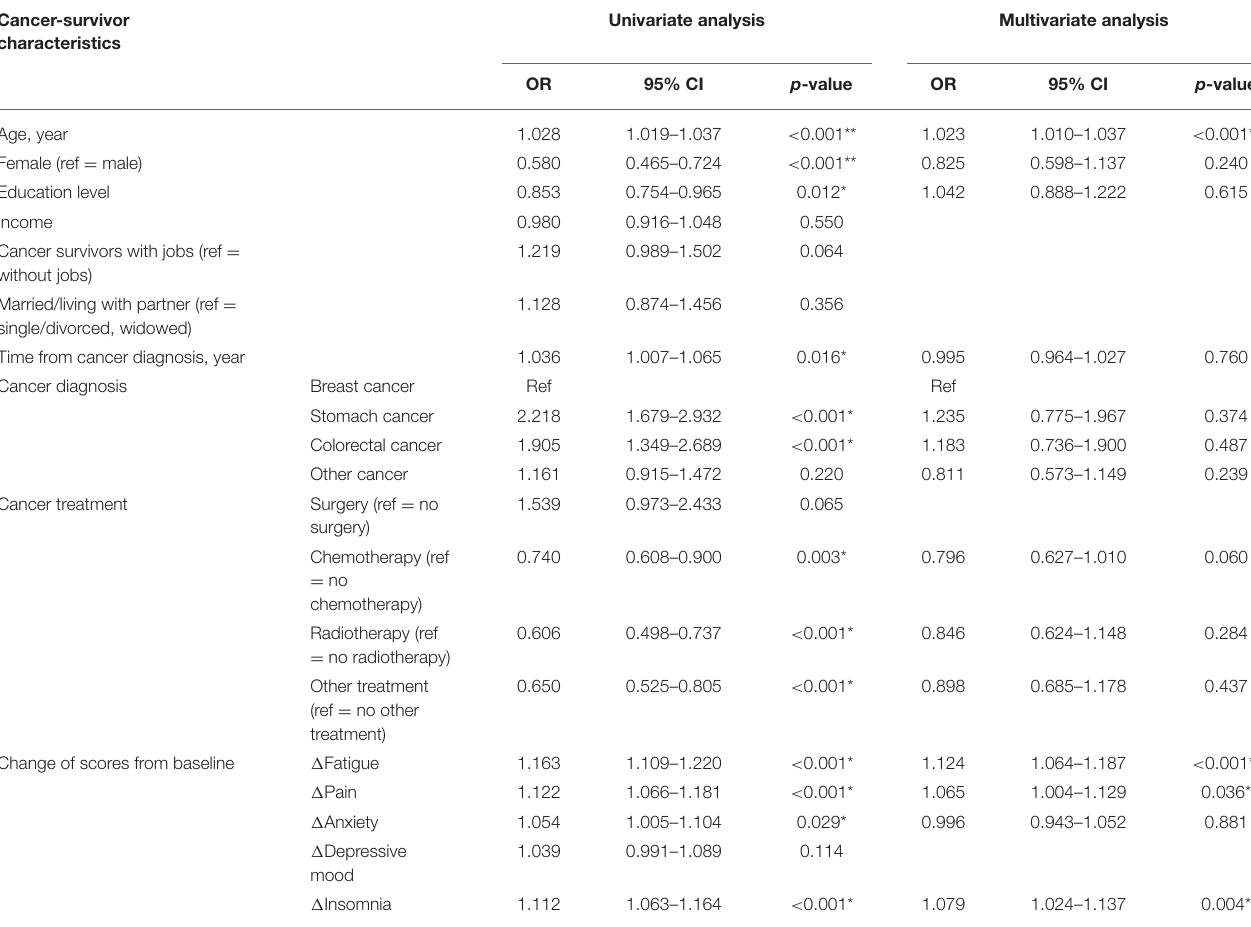
TABLE 3 | Predicting factors of a low distress level after